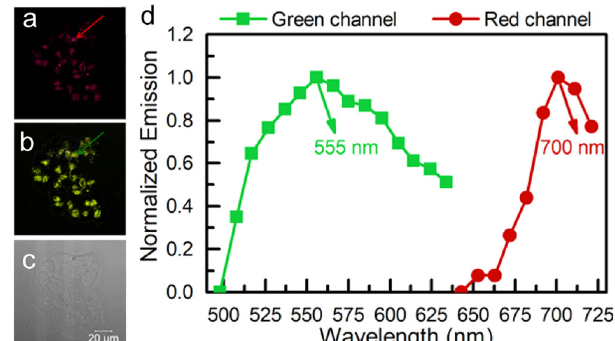
Fig. 7 The microscopic images and the in situ emission spectra. a Red and b Green c Bright channel of real color images of live HeLa cells stained with PPAB-PyS NPs (100 μ M) for 24 h. d In situ emission spectra presented with green and red color were acquired in the circular are as in ( a , b ) images. Red channel, λ ex = 633 nm, λ em = 643 – 721 nm; Green channel, λ = 488 nm, λ = 498 – 634 nm. ex em